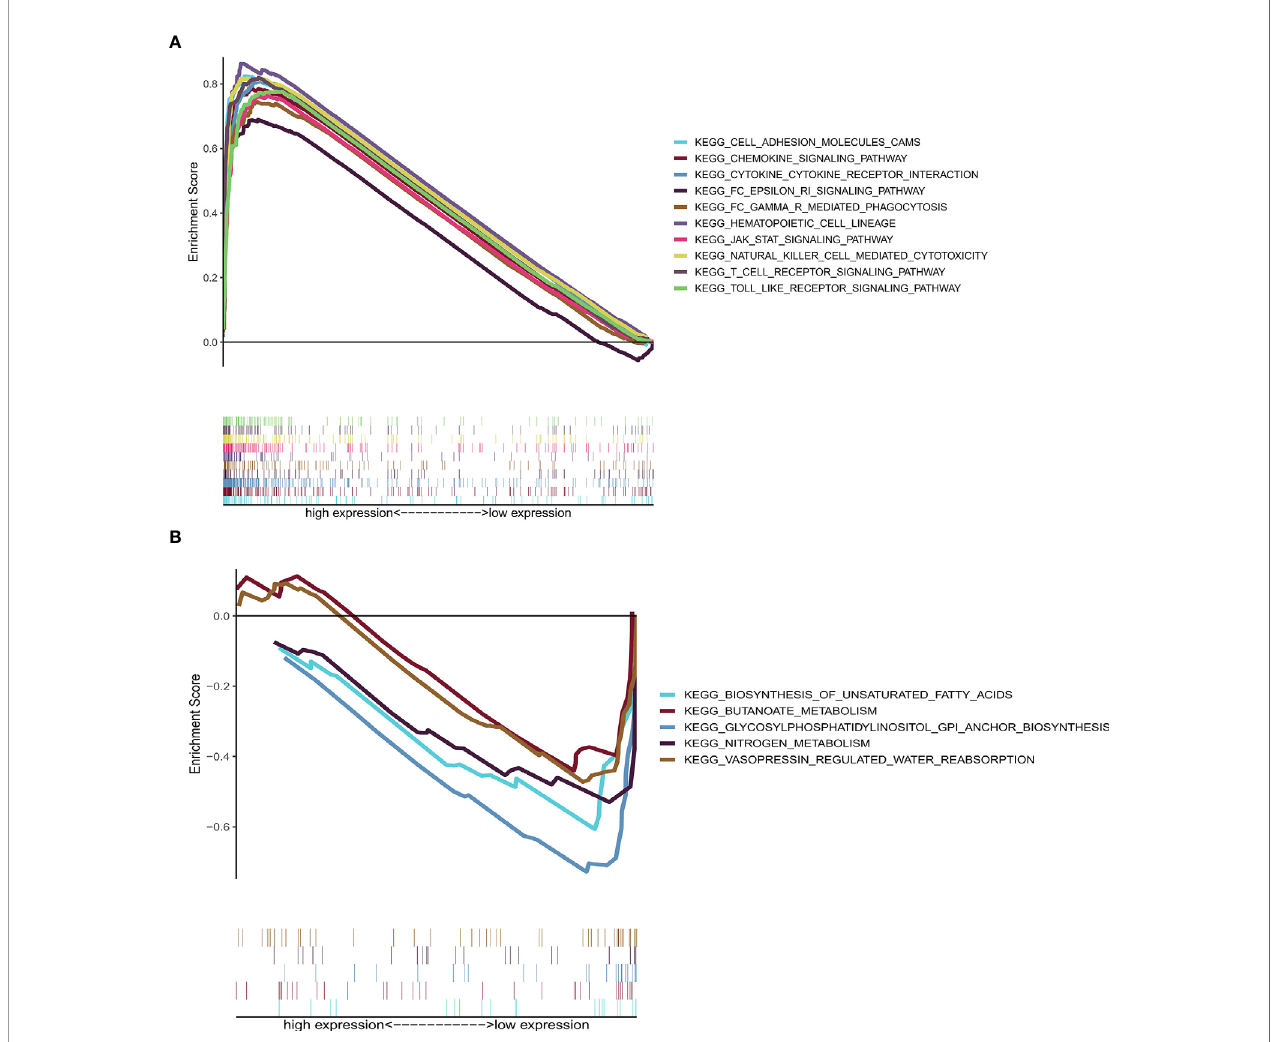
FIGURE 7 | GSEA of samples with high or low CD2 expression. (A) Top ten signi fi cant pathways associated with high CD2 expression (nominal p < 0.05 and FDR- adjusted q < 0.05). (B) Top fi ve signi fi cant pathways associated with low CD2 expression (nominal p <